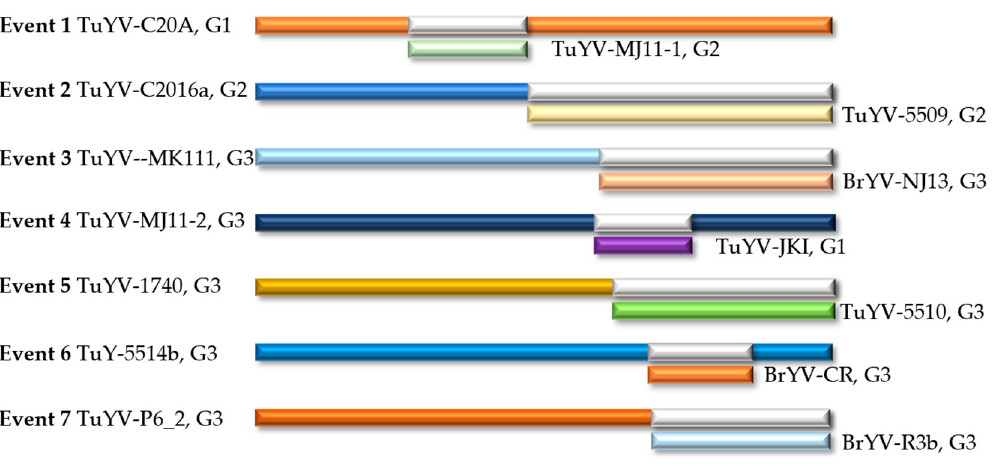
Figure 6. The schematic representation of the recombinants identified in this study. The long colored bars represent the genome of the recombinant. The shorter dark grey bars indicate the potential position of the recombinant, and the corresponding shorter colored bars indicate the donor fragment of the smaller parent. The abbreviation “G” after the train name stands for “group” according to the reference.